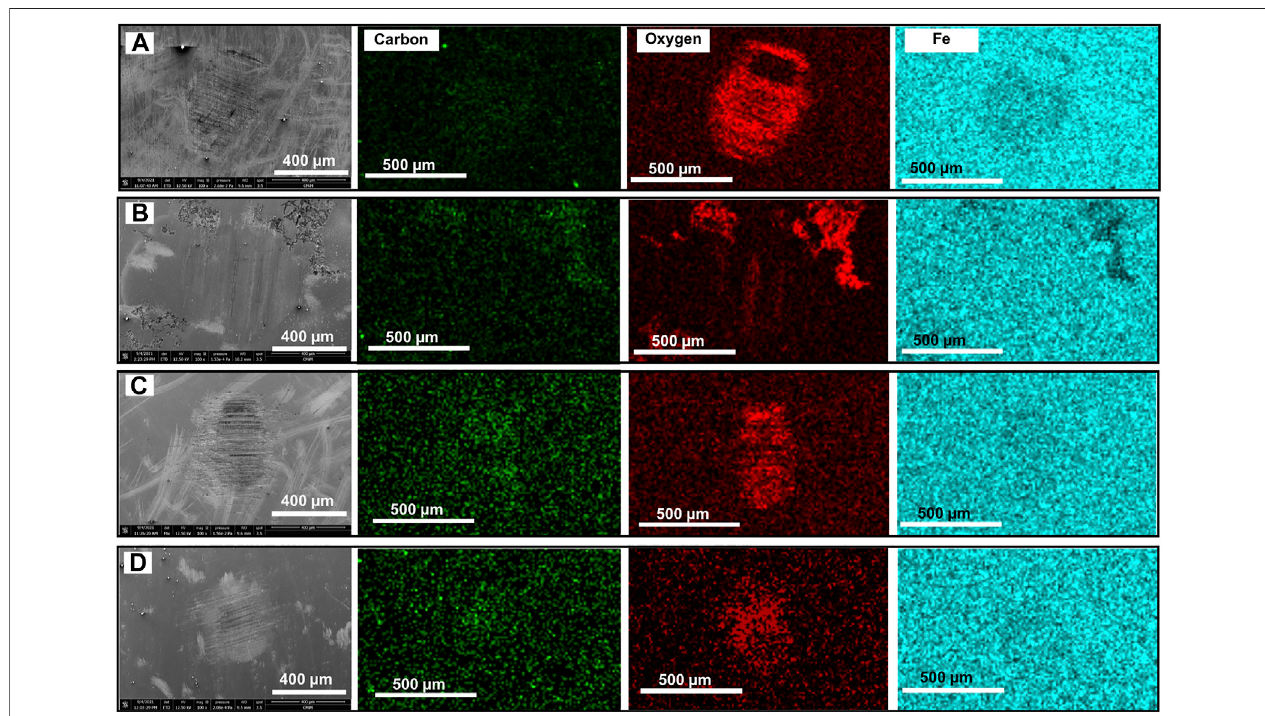
FIGURE 10 | EDS map of the worn scar the pin; lubricated by L1 (A) , L2 (B) , L3 (C) , and L4 (D) , indicating the elements of Carbon, Oxygen and Iron (Fe).